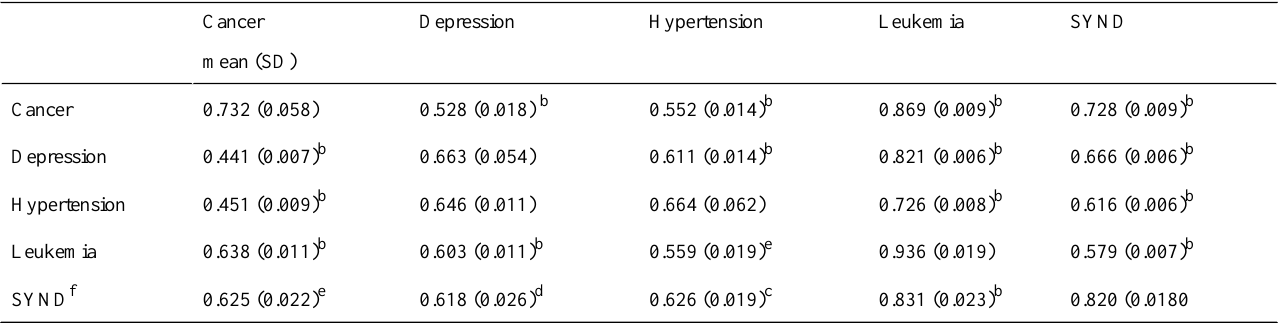
Table 4. AUPRC for homogeneous and heterogeneous classifiers. a